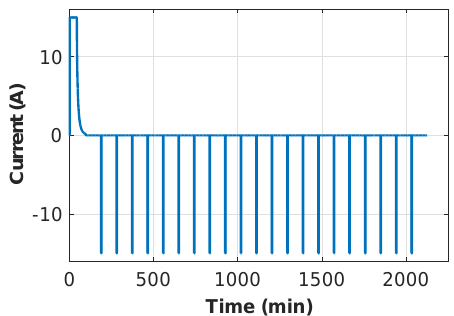
Figure 7. Battery’s discharge current profile.